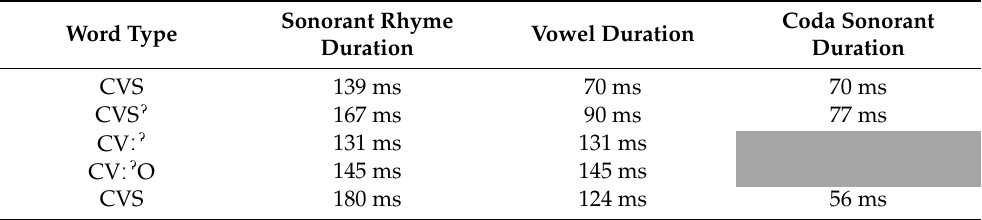
Table 7. Average rhyme, vowel, and sonorant durations in milliseconds per word type. Greyed out cells indicate the lack of a sonorant coda for CV